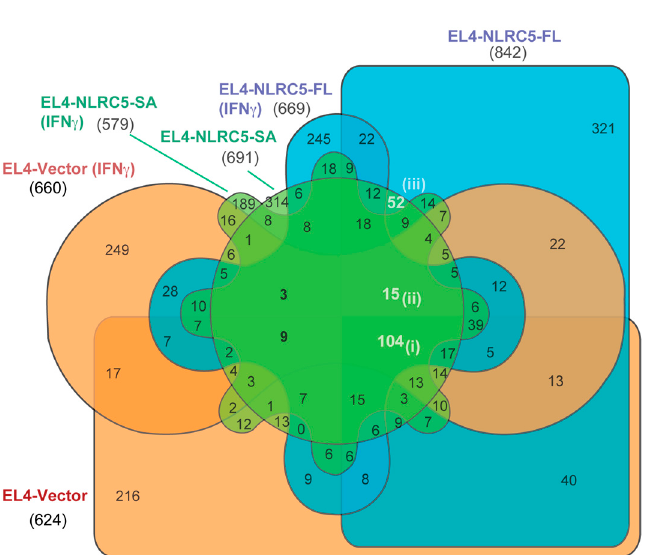
Figure 7. Potential immunogenic MAPs that could be identified using NLRC5-SA. Six-way Venn diagram showing the comparison of MAPs from all the three cell lines at steady state and after IFN γ stimulation. Table 3. Fifteen peptides commonly being presented by all EL4 cell types excluding EL4-vector cells. Numbers in brackets indicate the increase in amino acid mass due to possible post translational modi fi cation.